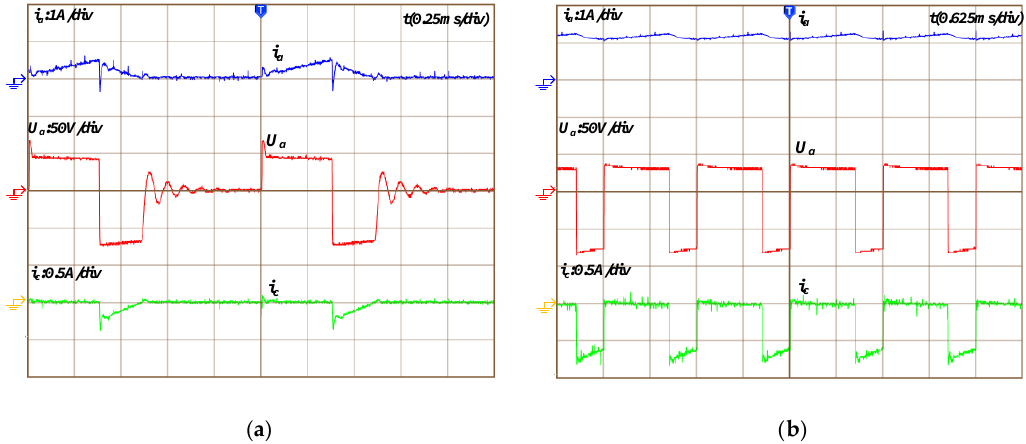
Figure 13. The experimental waveforms of static charging mode. ( a ) At 30% duty cycle. ( b ) At 70% duty cycle.